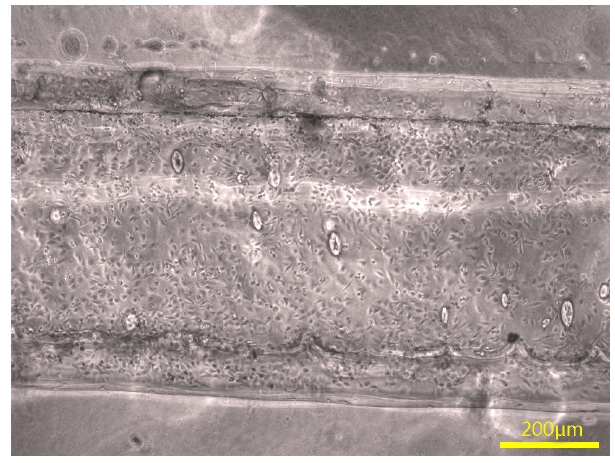
Figure 10. Adhesion of cells in the macrochannel.